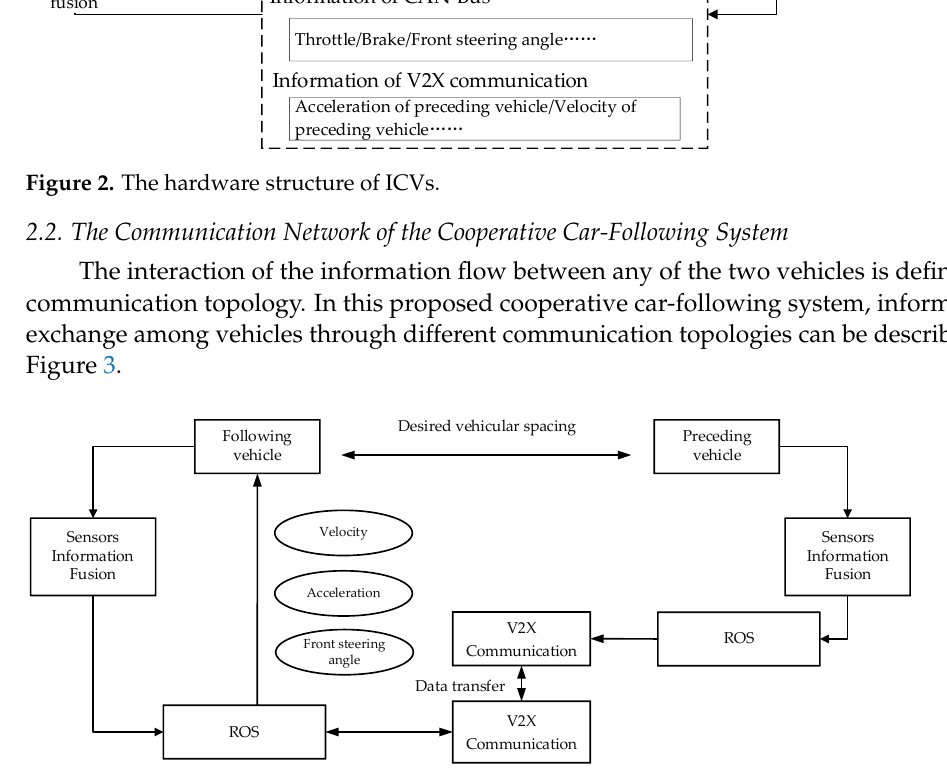
Figure 2. The hardware structure of ICVs.